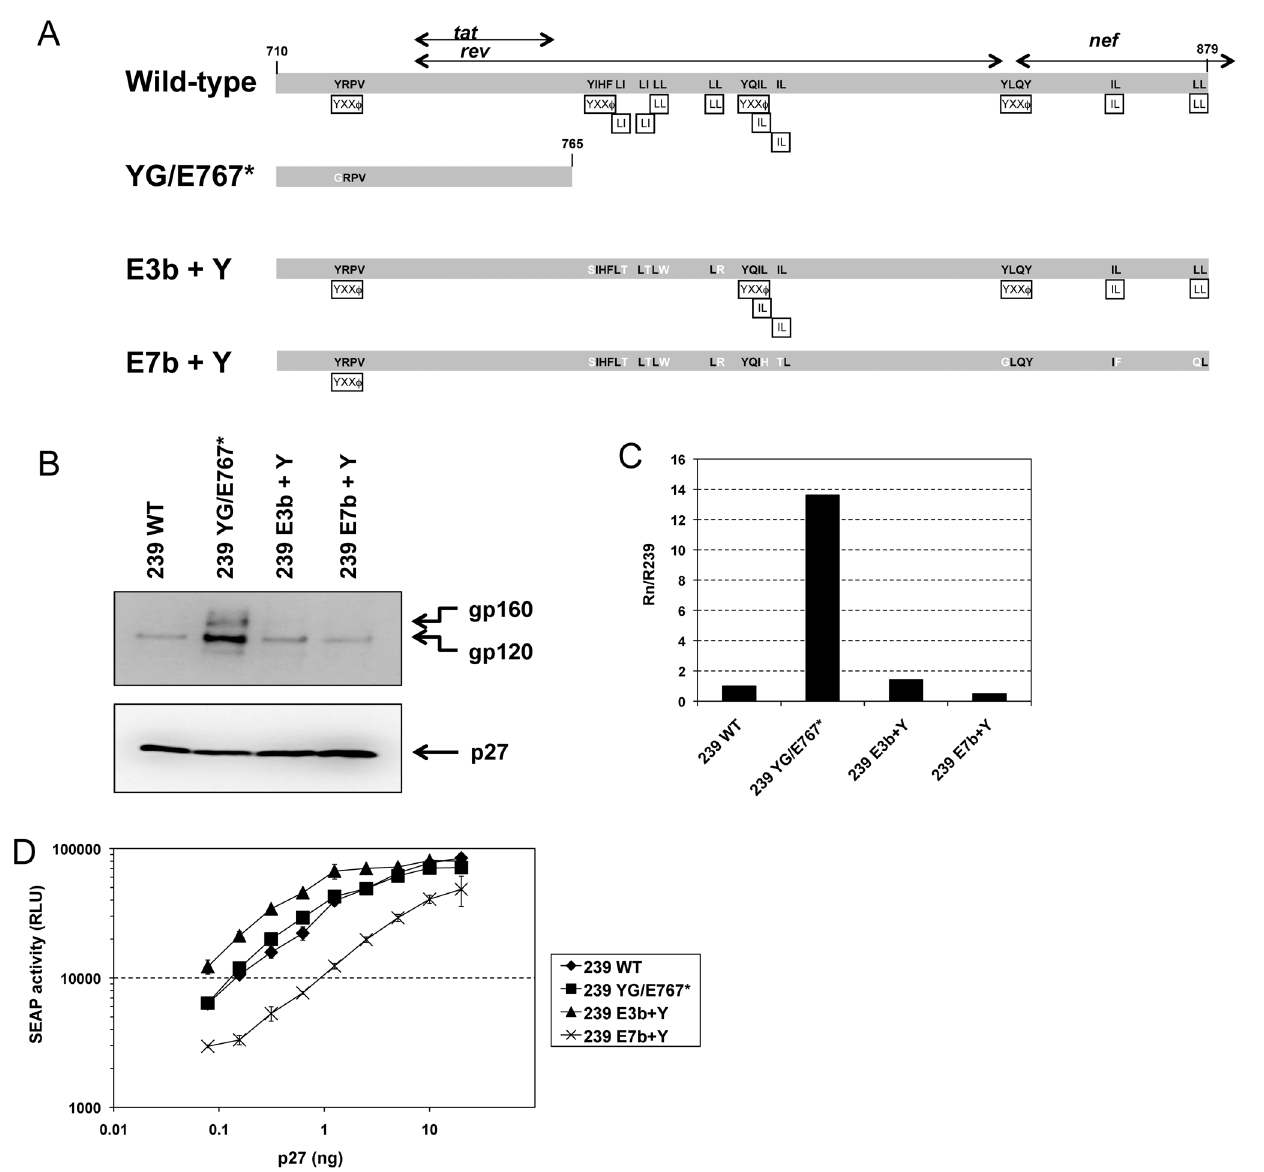
Figure 6. Role of the membrane-proximal YXX W motif. ( A ) Schematic representation of additional mutations within the cytoplasmic domain of gp41. Black boxes indicate location and type of potential trafficking motifs. Black arrows represent overlapping reading frames for rev , tat , and nef , respectively. ( B and C ) Incorporation of mutant Env into virions. Viruses were produced by transfection of HEK293T cells and virions were pelleted from the clarified supernatants. (B) gp160/gp120 (top panel) and p27 (bottom panel) were detected by Western blot using antibody 3.11H and 2F12, respectively. (C) Relative Env incorporation into virions. The ratios of gp120 to p27 were calculated by phosphorimaging analysis. Data are presented as the gp120:p27 ratio of mutant virions (Rn) relative to the gp120:p27 ratio of SIVmac239 wild-type (WT) virions (R239). ( D ) Infectivity of mutant viruses. Stocks were normalized for p27 content and used to infect C8166-45 SIV-SEAP cells with serial dilutions. SEAP activity 3 days after infection. Error bars indicate standard deviation of